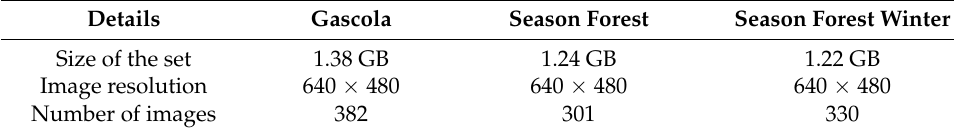
Table 2. Details of the content of selected TartanAir